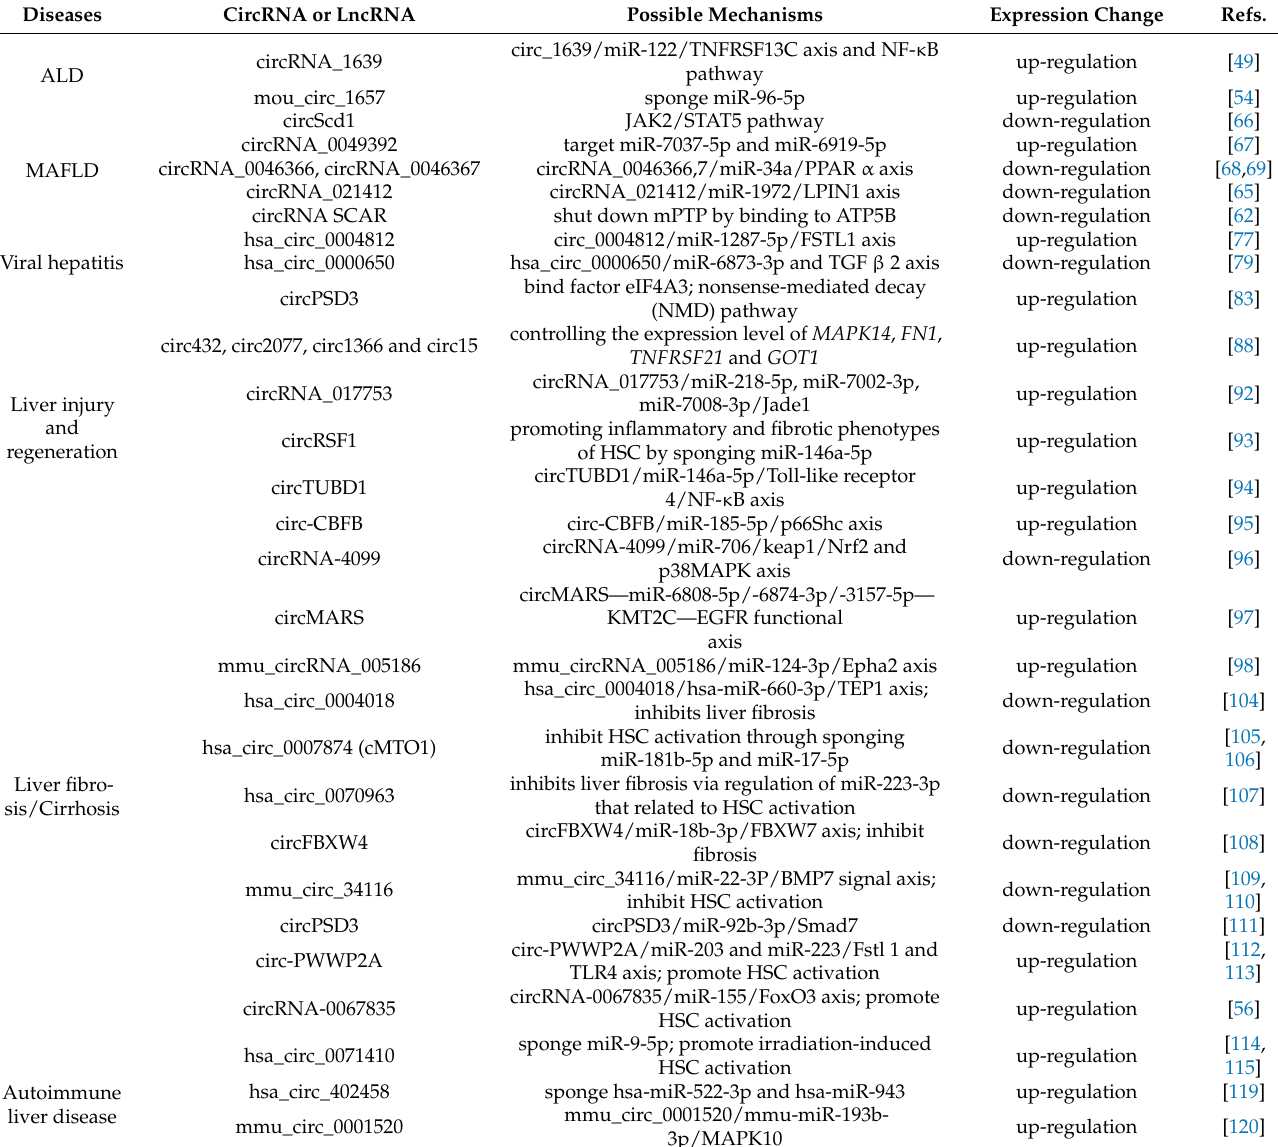
Table 1. Summary of circRNAs involved in chronic liver